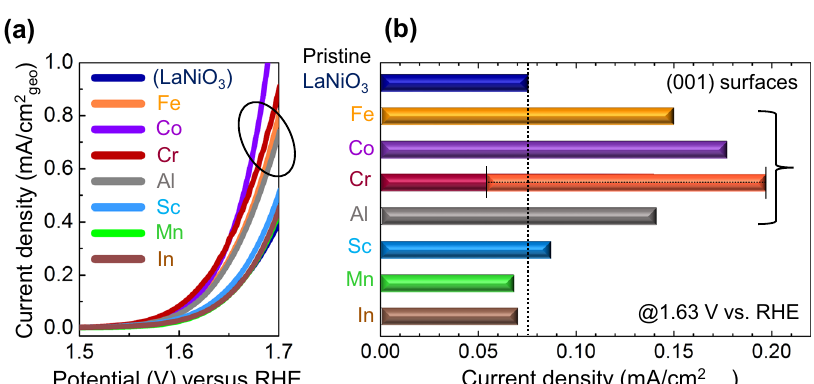
Fig. 4 OER activity comparison of the doped LaNiO 3 (001) cubic surfaces. a This plot shows the variation of the OER current density of the fi lms with 5% doping as a function of applied potential vs. RHE. b The bar graph compares the difference between the OER current densities of the doped (001) surfaces measured at 1.63 V vs. RHE. For an easier comparison, a black vertical line is added on the graph, showing the OER current density of the pristine (001) surface. As denoted, Fe, Co, Cr, and Al have a notably bene fi cial effect on the OER activity, while Sc, Mn, and In make little